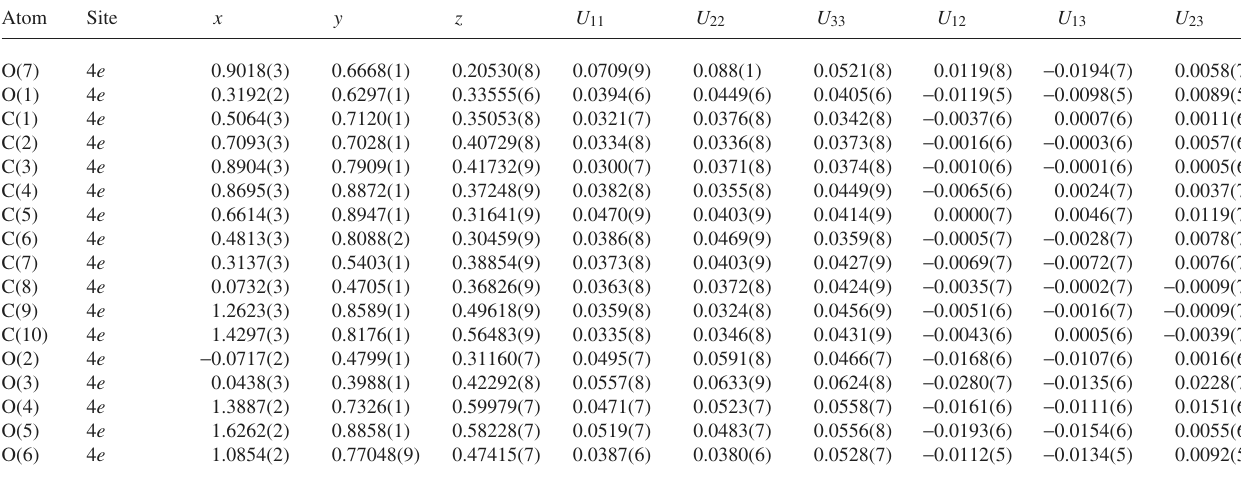
Table 3. Atomic coordinates and displacement parameters (in Å 2 )